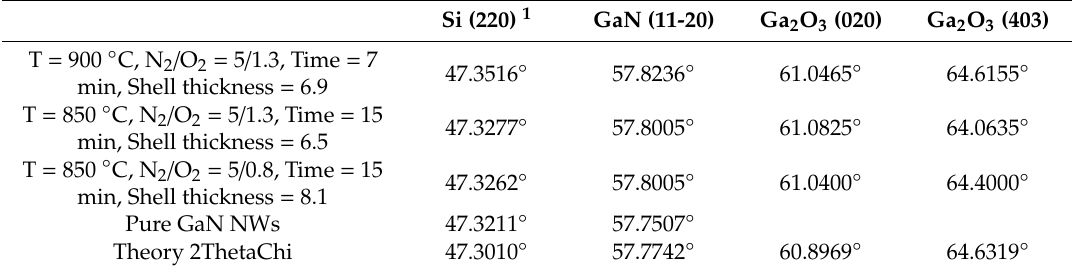
Table 2. Peak positions for three di ff erent samples before and after dry oxidation.